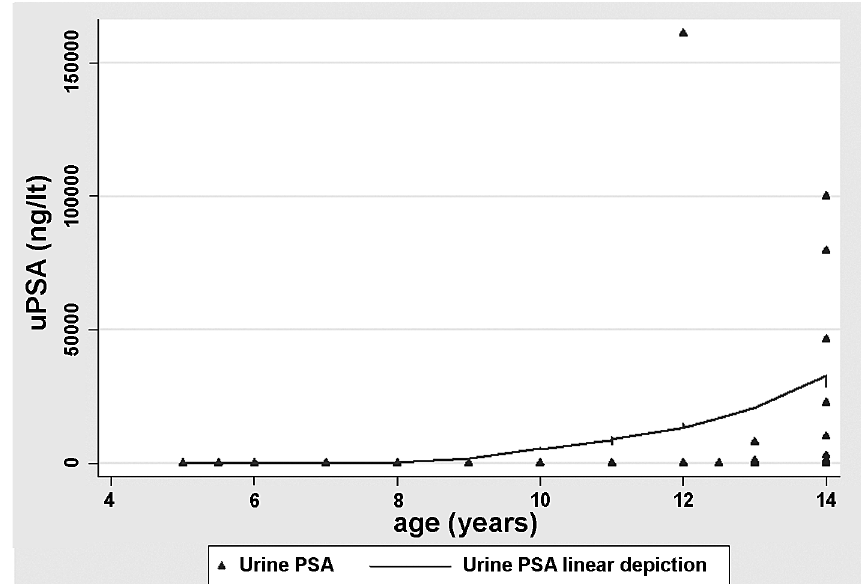
Figure 1 – Urine PSA in boys in relation to age. There is a sharply increase of uPSA in boys after the age of 12 years, when they come into adolescence.